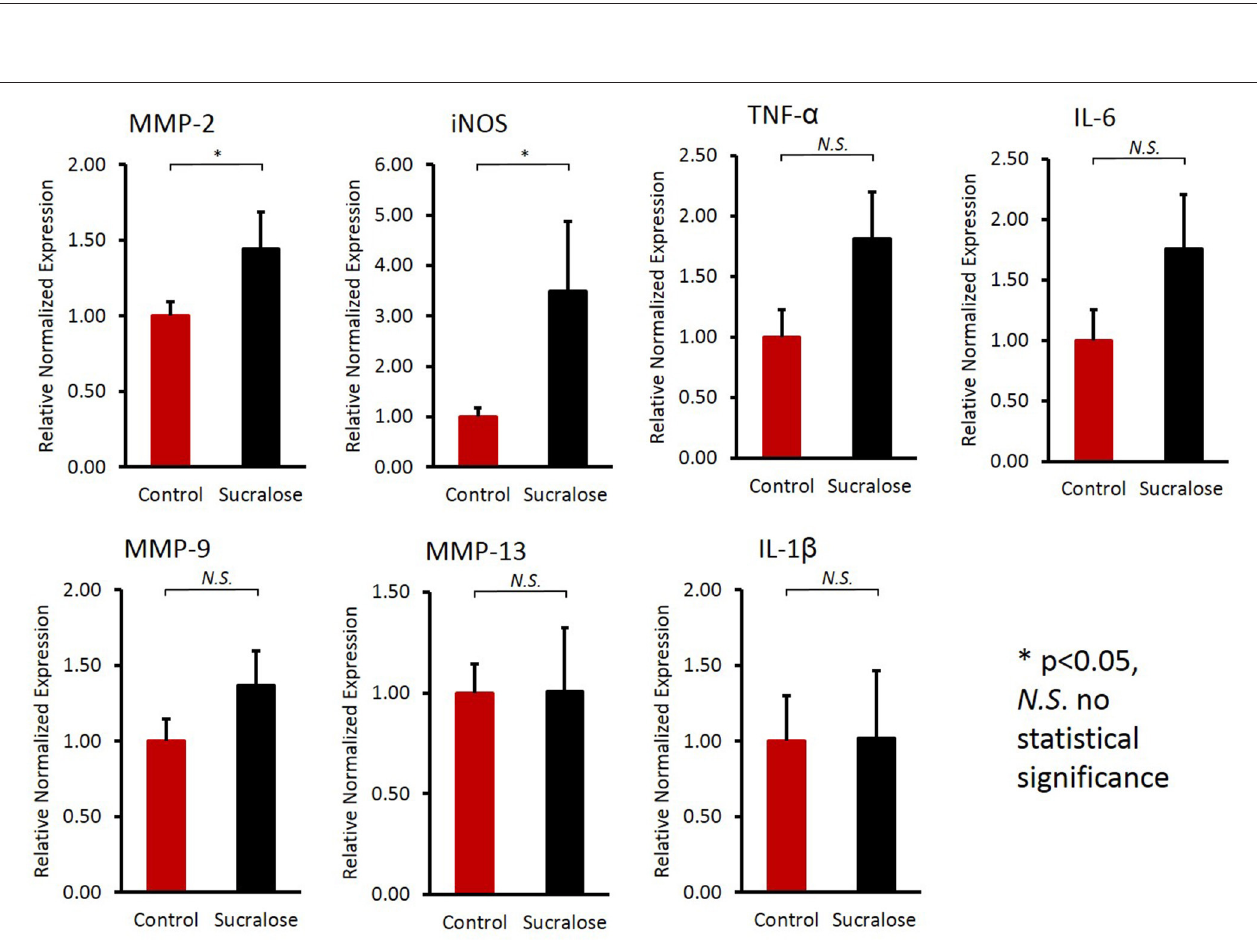
FIGURE 7 | Sucralose consumption increased the gene expression of inflammatory markers in the liver, as examined by qRT-PCR. The mRNA expression of matrix metalloproteinase 2 (MMP-2) and inducible nitric-oxide synthase (iNOS) was elevated in sucralose-treated mice. * p < 0.05, N.S., no statistical significance.